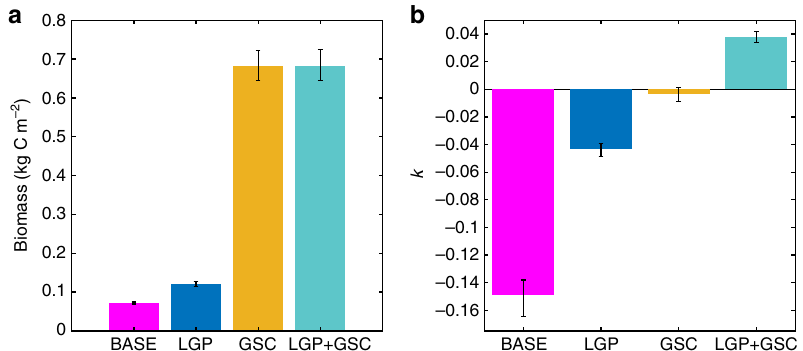
Fig. 4 Mean biomass and scaling coef fi cient for ecosystems with TE as a function of size. a Biomass and b scaling coef fi cient ( k ) with size dependence of TE based on Eqn (4). Error bars show 95% con fi dence intervals ( n = 5000 for all